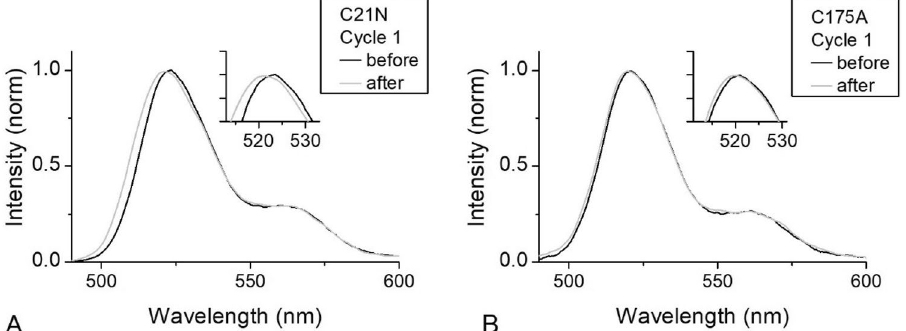
Figure 3. Emission spectra of ( A ) C21N mSAASoti and ( B ) C175A mSAASoti before (black line) and after (grey line) 500 s of 470 nm